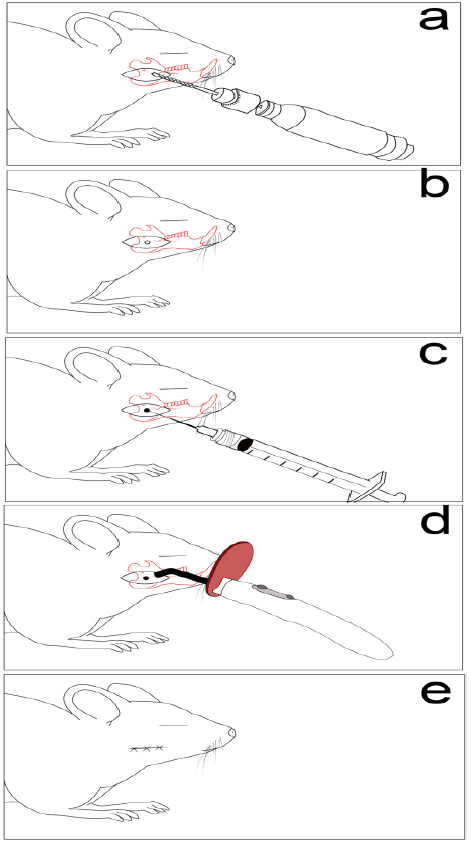
Figure 1. Non-critical mandible bone defect used in the experimental animals. ( a ) Defect drilling ( b ), a circular bone defect (2/2 mm) ( c ), defect filling with dental composites ( d ), biomaterial polymerization ( e ), and layers suture.